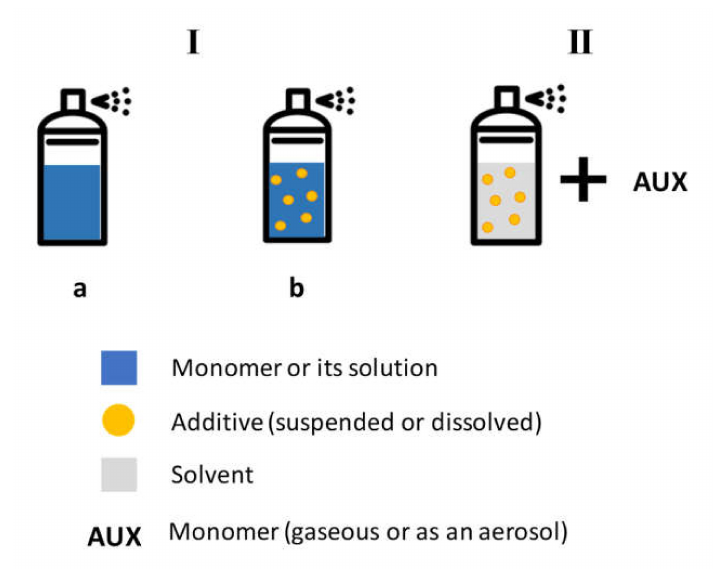
Figure 4. Scheme of possible coupling of atomization sources to atmospheric pressure (AP)